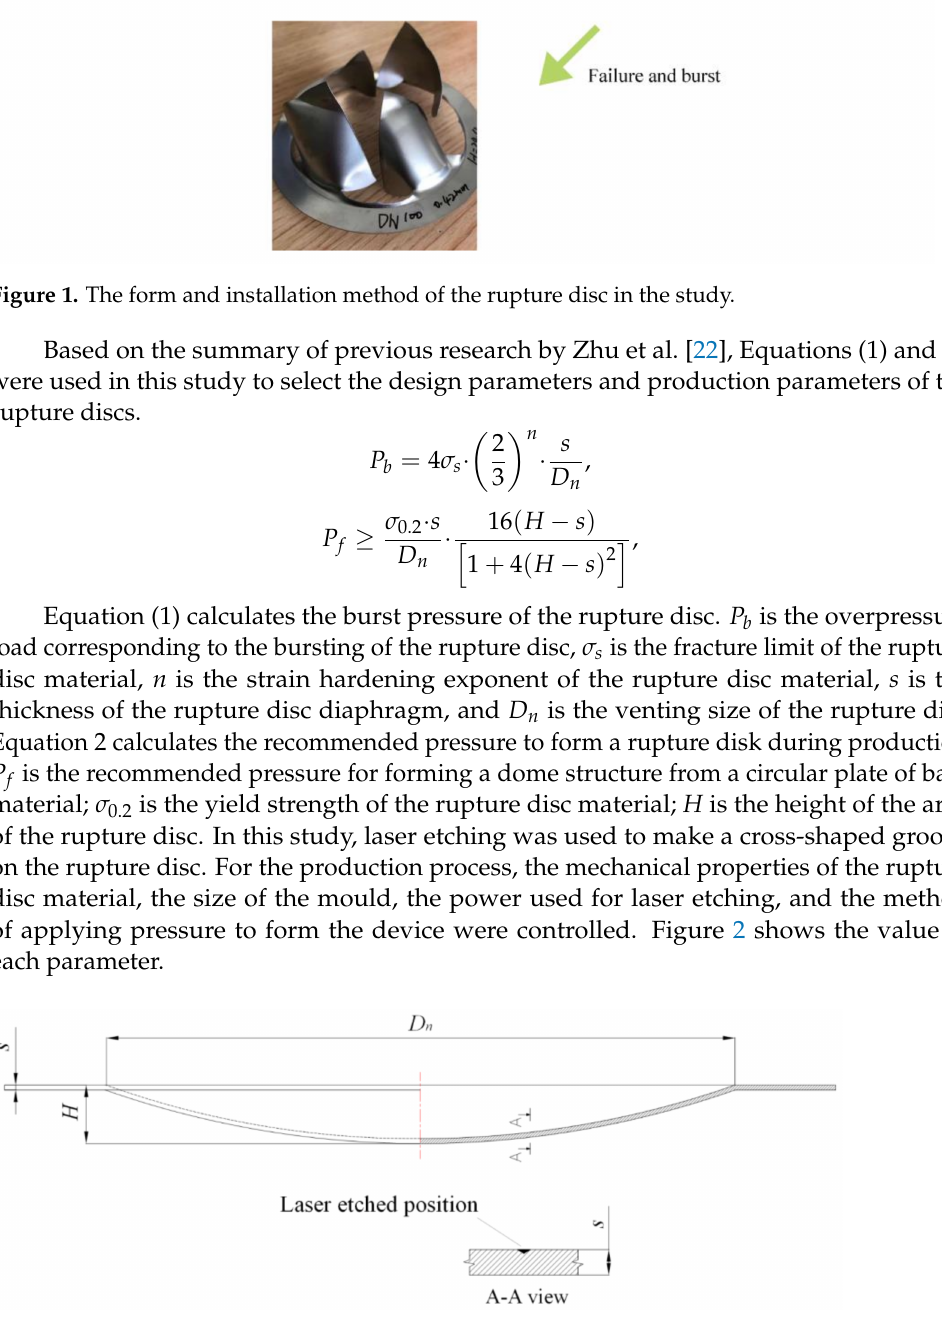
Figure 2. Description of the rupture disc’s design